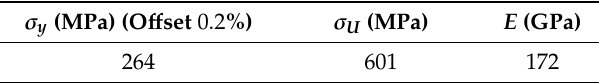
Table 2. Basic mechanical properties.